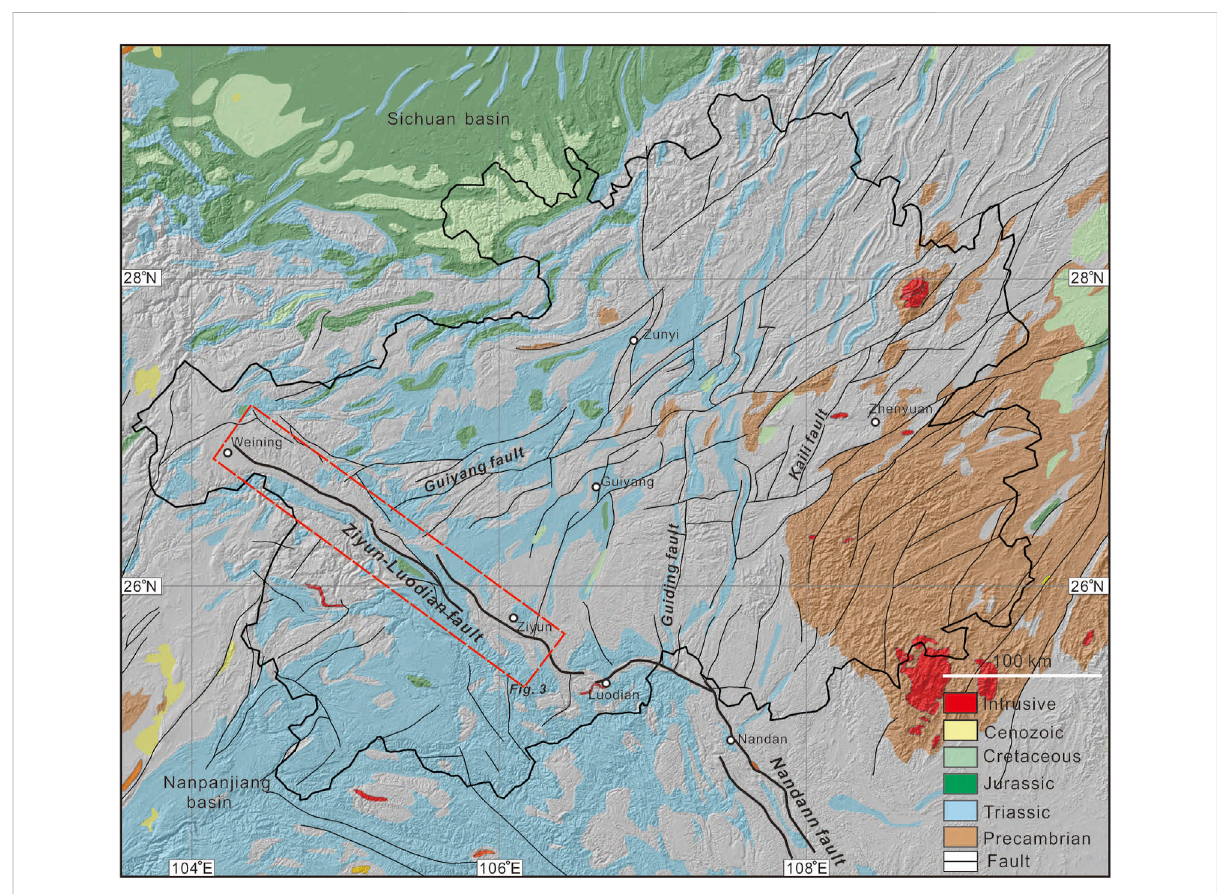
Geological map of the Guizhou Province and adjacent regions. The Guizhou Province is tectonically located in the SW margin of the Yangtze Block, adjacent to theJiangnanorogento theeast, theSichuanBasin tothenorth, theSanjiangorogenicbelt tothewest, andtheNanpanjiang basin to the southwest. The NW-trending Ziyun-Luodian fault runs across the Yunnan, Guizhou, and Guangxi Provinces in SW